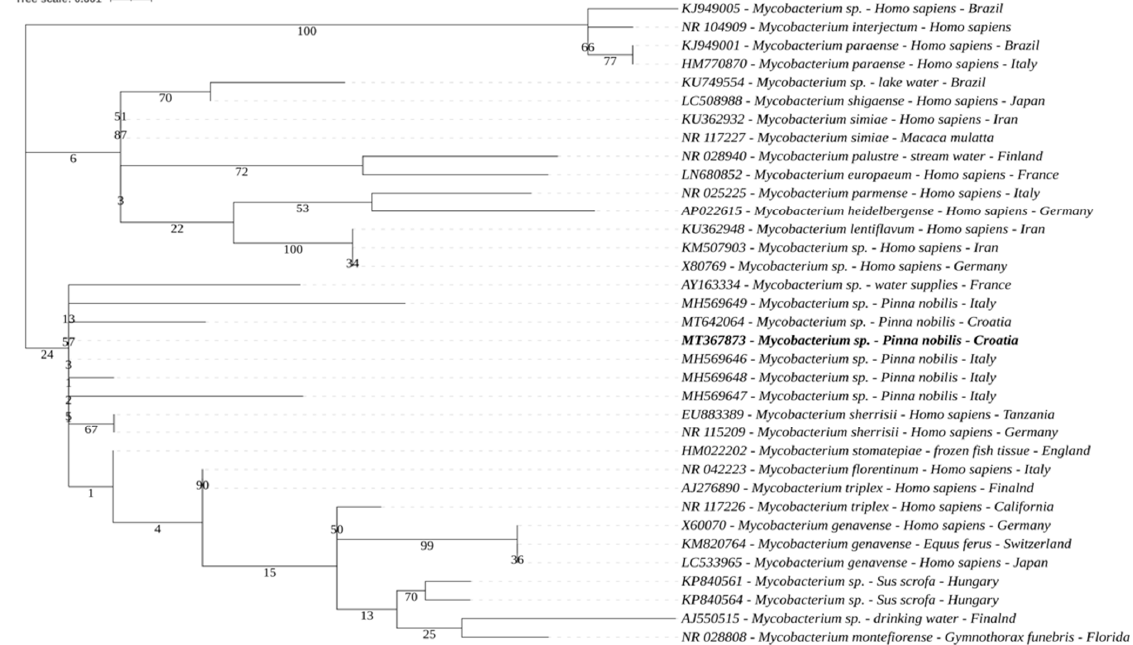
Figure 9. Maximum likelihood phylogenetic tree for Mycobacterium spp. The numbers on the branches represent bootstrap values.